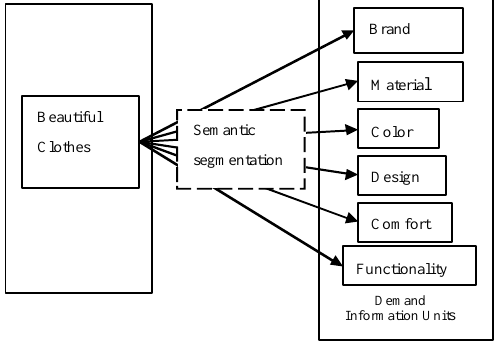
Fig.3. Demand semantic segmentation